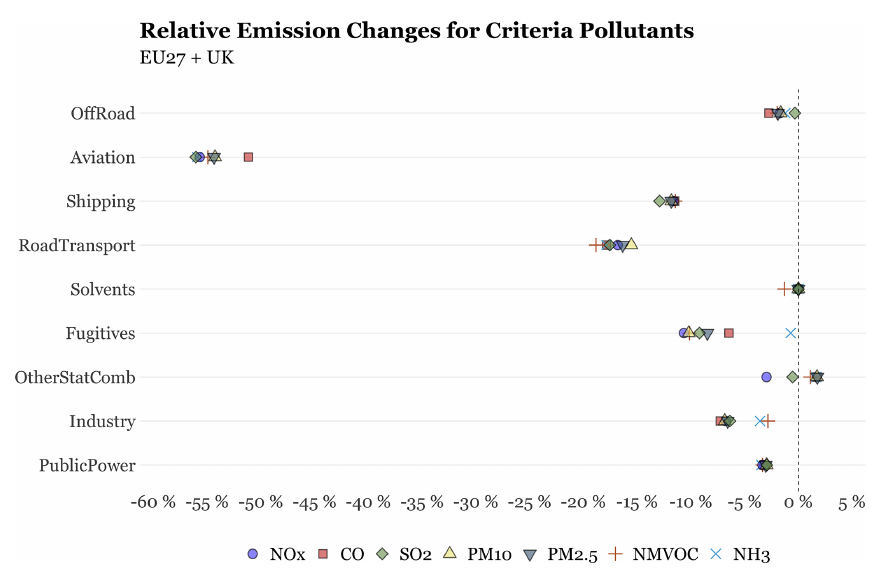
Figure 8. Relative decline in emissions of criteria pollutants [%] by sector and species between 1 January and 31 December 2020 for EU27 + UK. For the shipping sector the relative differences consider both inland and sea shipping sectors.